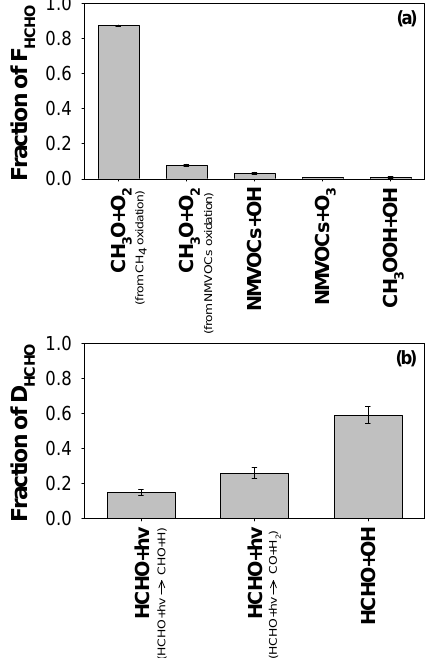
Fig. 8. Budget analysis of the HCHO formation ( F HCHO ) and HCHO destruction ( D HCHO ) : (a) contribution of five major HCHO formation reactions to F HCHO in the ITCT 2K2 ship plume under moderately stable MBL condition. Here, the contributions from NMVOC oxidations (the second, the third and the fourth bars) were estimated from: (i) the calculation of CH 3 O radical production rates from the NMVOC oxidations, (ii) summed rates of NMVOCs (alkane species)+OH reactions, and (iii) summed rates of NMVOCs (mainly, alkene species, including isoprene)+O 3 reactions from the modified Lurmann chemical mechanism and (b) contribution of three major HCHO loss reactions to D HCHO in the ITCT 2K2 ship plume under moderately stable MBL